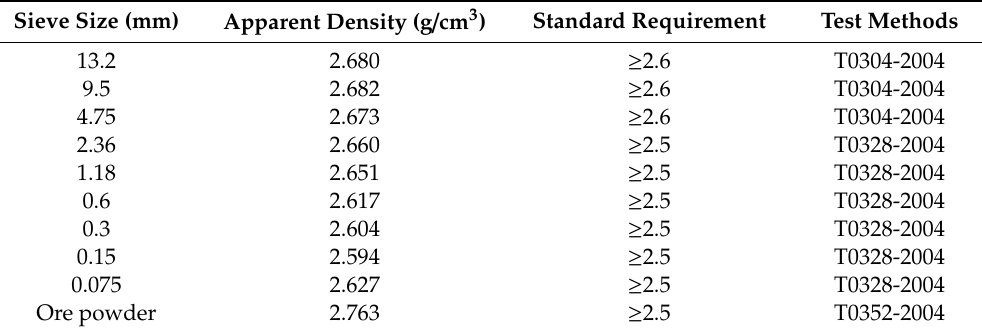
Table 2. The key index of two type of asphalt.